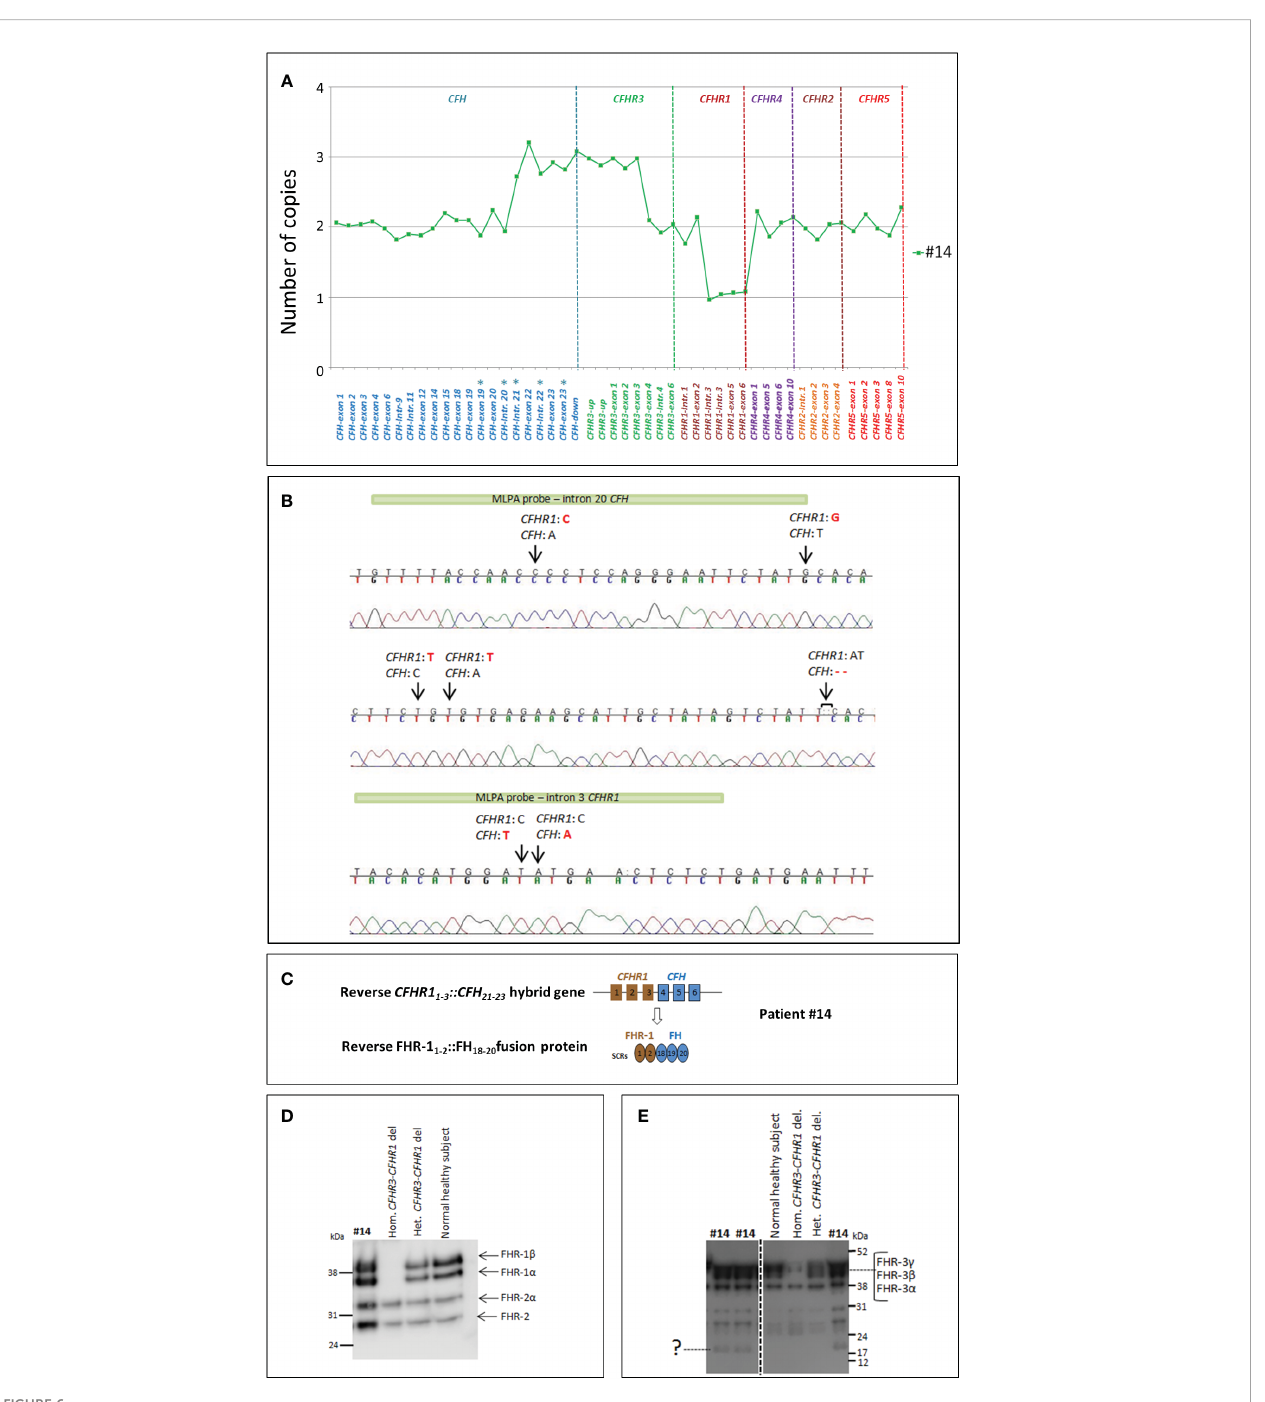
FIGURE 6 Identi fi cation of the reverse CFHR1 1-3 ::CFH 21-23 hybrid gene in patient #14. (A) The results of MLPA show in patient #14 three copies of both CFH exons 21-22-23 and CFHR3 exons 1-2-3, 2 copies of CFHR1 , one of them lacking exons 4-5-6. These data suggest the presence of a reverse CFHR1 1-3 ::CFH 21- 23 hybrid with a partial duplication of CFHR3 1-3. The analysis has been performed with the SALSA MLPA P236- CFH -region Kit (MRC Holland) implemented with homemade probes (indicated by asterisks) analyzed in a separate assay and covering the last exons and introns of the CFH gene (27). (B) Sequence of the genomic breakpoint of the CFHR1 1-3 ::CFH 21-23 hybrid gene, mapped between chr1:196796490 (intron 3 of CFHR1 ) and chr1:196711901 (intron 20 of CFH). Arrows indicate the nucleotide differences between CFH and CFHR1. The green bars highlight the target sequence